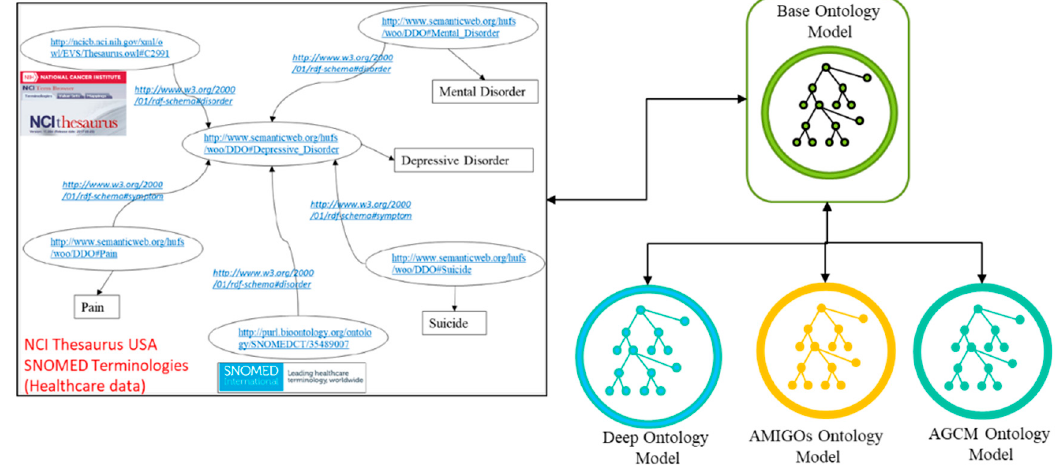
Figure 5. Developed ontology models of affective human health conditions.